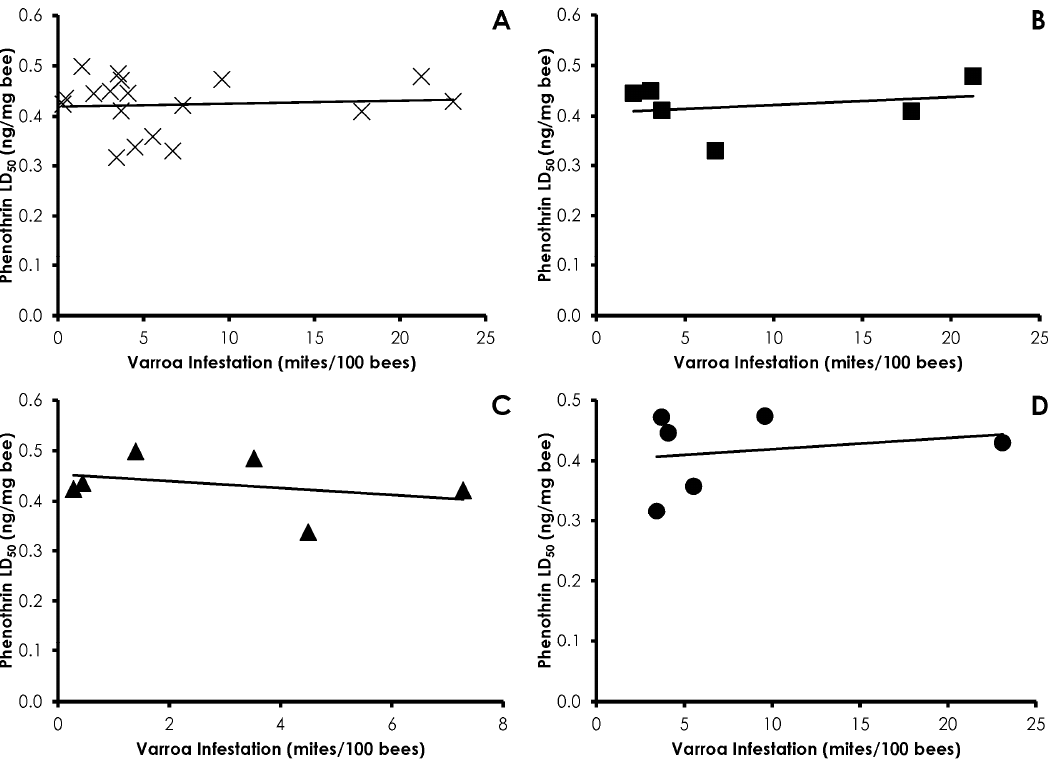
Figure 3. Influence of Varroa infestation on phenothrin sensitivity in all treatments ( A ); Control ( B ); Amitraz ( C ); and IPM ( D ) treatment groups. There was no significant effect of Varroa infestation on phenothrin sensitivity in any instance.